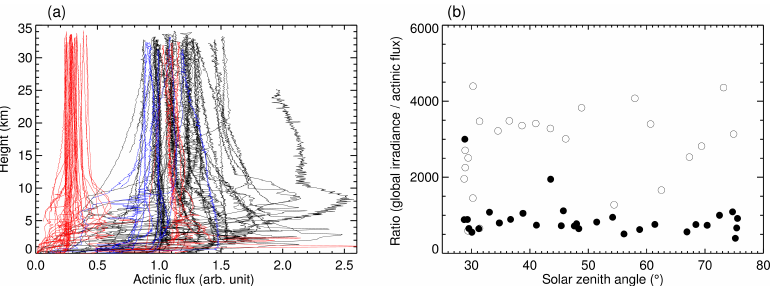
Figure 3. (a) Measured actinic flux profiles in 2006 (black lines), 2007 (red lines), 2008, and 2010 (blue lines). (b) Ratio between the global irradiance at the ground measured at 11:30UTC at De Bilt and the actinic flux profile measurement at 4m height at 11:30UTC at De Bilt. Results for 2006 are marked as filled circles; results for 2007 are in open circles.